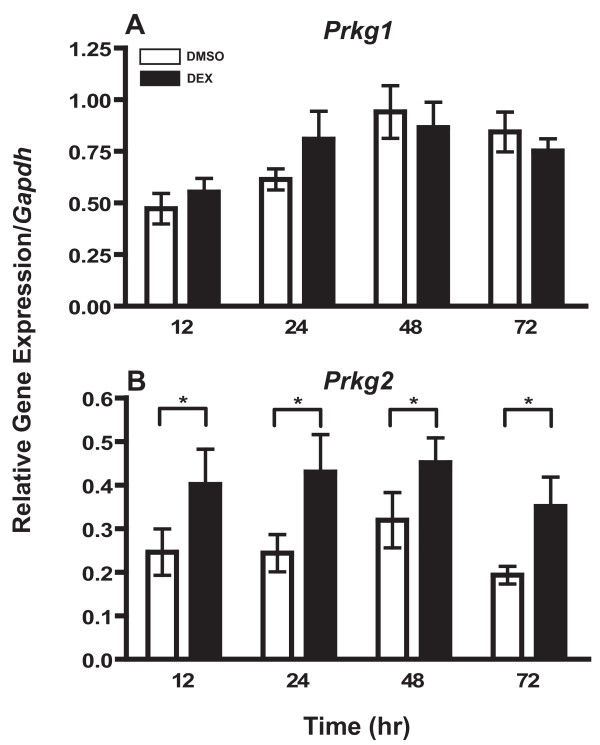
DEX increases Prkg2 expression in chondrocytes. Primary chondrocytes were incubated with DMSO or 10-7 M DEX for 12 to 72 hours, and Prgk1 (encoding cGMP-dependent protein kinase I, A) and Prkg2 (encoding cGMP-dependent protein kinase II, B) mRNA levels were determined by real-time PCR relative to Gapdh. While Prkg1 expression remained relatively unchanged over time and in response to DEX treatment, Prkg2 levels were significantly increased during the time course and in response to DEX. Data represent mean ± SEM from three or four independent trials (*P < 0.05).